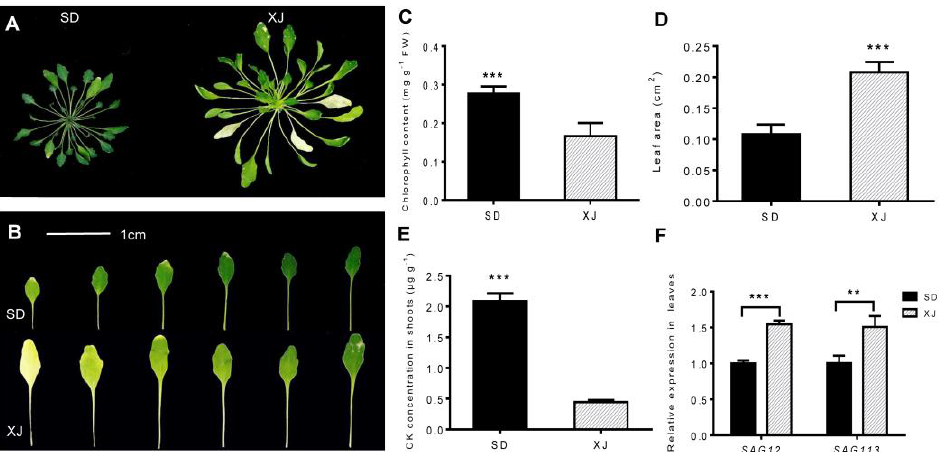
Figure 2. Senescence analysis of SD and XJ plants cultured in a hydroponic system for 6 weeks. ( A ) The growth state of the shoots. ( B ) Comparison of SD and XJ plants with 9th–14th leaves. Bars = 1 cm. ( C ) Total chlorophyll content in leaves of SD and XJ plants. ( D ) Leaf area values for SD and XJ plants. ( E ) The concentration of CK in SD and XJ shoots. Concentrations of CK in SD and XJ. ( F ) Expression of SAG12 and SAG113 in leaves of two ecotypes. Data are presented as means ± SD and t -test was used for statistical analysis. (** p < 0.01 and *** p < 0.001).